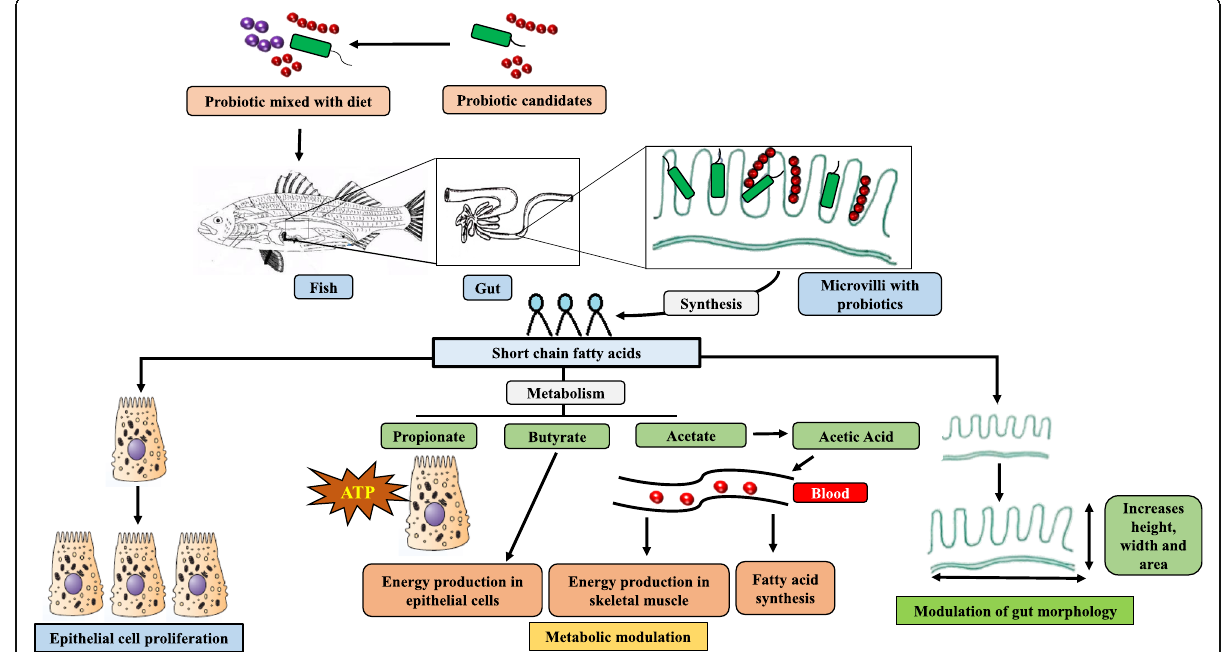
Fig. 3 Effects of probiotics on metabolites production by gut microbial